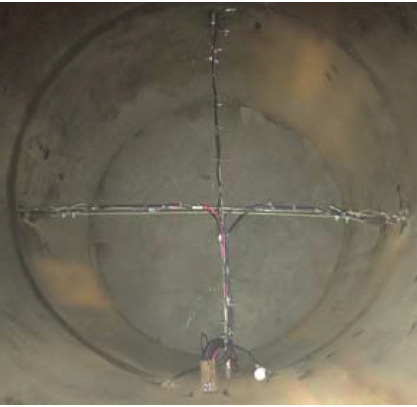
Figure 8: Placement of the